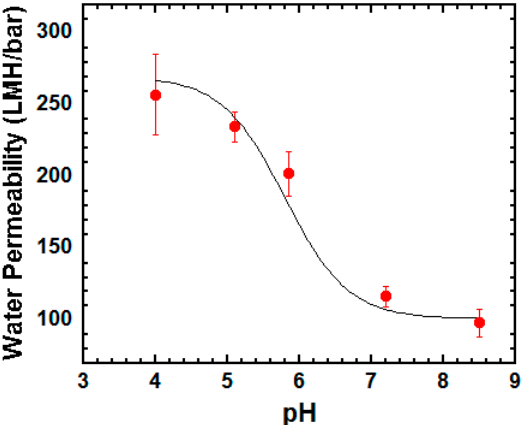
Figure 3. XPS survey spectra of ( a ) bare PVDF and ( b ) functionalized PVDF membranes (PVDF-PAA-PAH-ENZ). ( c ) C1s core-level spectra and ( d ) N1s core-level spectra of the functionalized PVDF membrane.